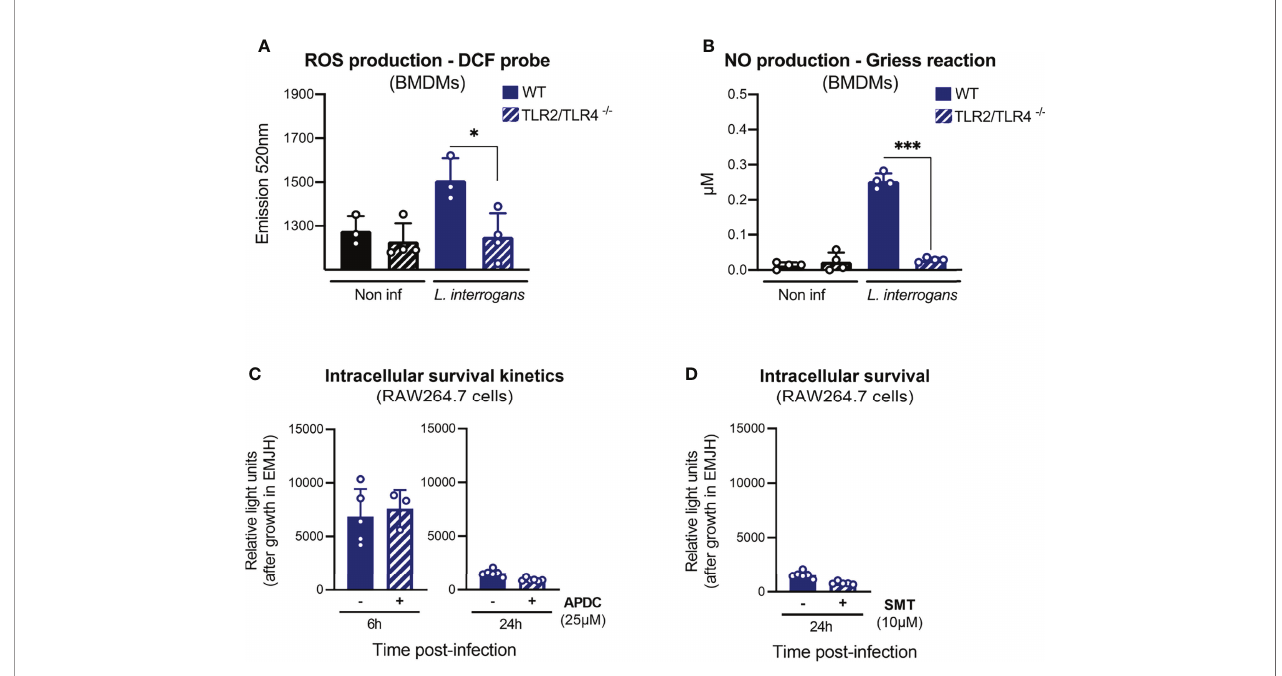
FIGURE 6 | Internalized leptospires are not degraded by ROS or NO. (A) ROS production, measured by DCF probe, in WT and TLR2/TLR4 dko BMDMs upon 6 h of infection with L. interrogans serovar Manilae strain L495. (B) NO production, measured by Griess reaction, in WT and TLR2/TLR4 dko BMDMs upon 24 h infection with L. interrogans serovar Manilae strain L495. (C) Intracellular survival 6 and 24 h post-infection of L. interrogans serovar Manilae strain MFLum1 in RAW264.7 treated with 25 µM ROS-inhibitor APDC and infected during 1 h with subsequent gentamicin protection assay. Intracellular survival was directly assessed by luminescence measurement on cell lysates diluted in EMJH. (D) Intracellular survival 24 h post-infection of L. interrogans serovar Manilae strain MFLum1 in RAW264.7 treated with 10 µM NO-inhibitor SMT and infected during 1 h with subsequent gentamicin protection assay. Intracellular survival was directly assessed by luminescence measurement on cell lysates diluted in EMJH. (A – D) Bars correspond to mean +/- SD of technical replicates ( n > 3). Data presented are representative of at least two independent